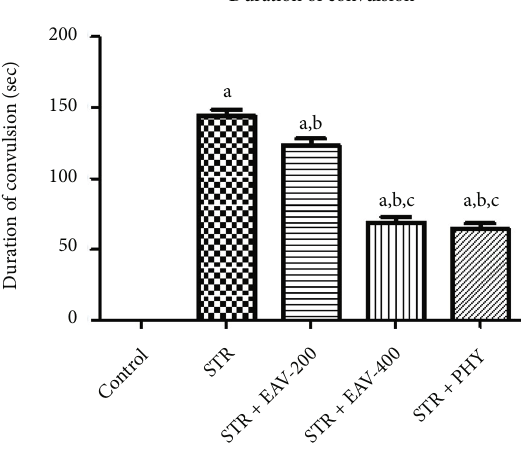
Figure 2: Graph showing the impact of EAV-200, EAV-400, and PHY on the duration of convulsion. All values are mean ± SEM ( n = 6 ). a p < 0 : 001 compared to control, b p < 0 : 001 compared to STR, c p < 0 : 001 compared to STR +EAV-200, c p < 0 : 05 STR + EAV-400 compared to STR